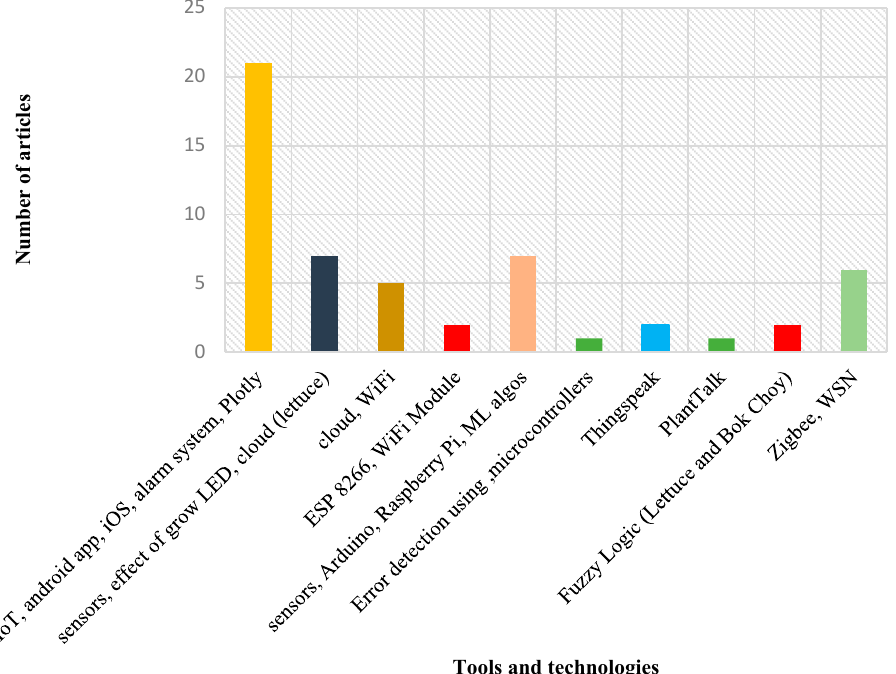
Figure 2. State of the art of hydroponic farming.